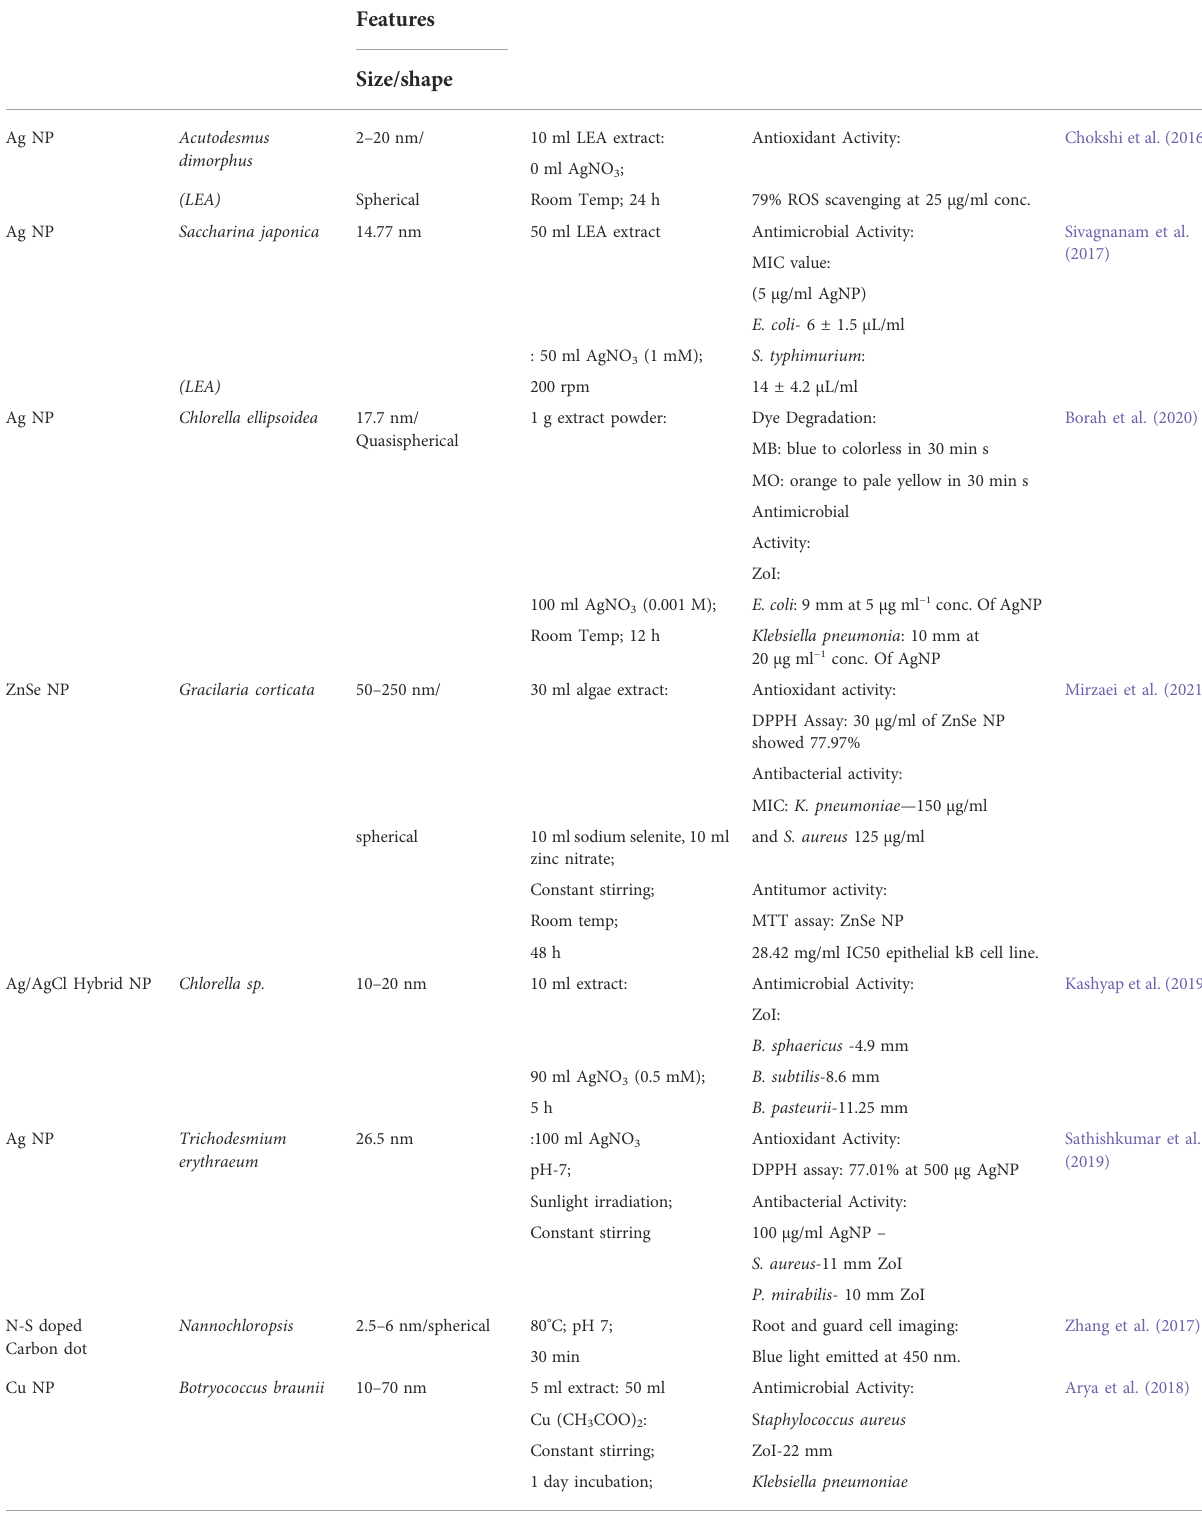
TABLE 5 Green synthesis of Nanomaterials from Algae and lipid extracted algal (LEA) biomass.